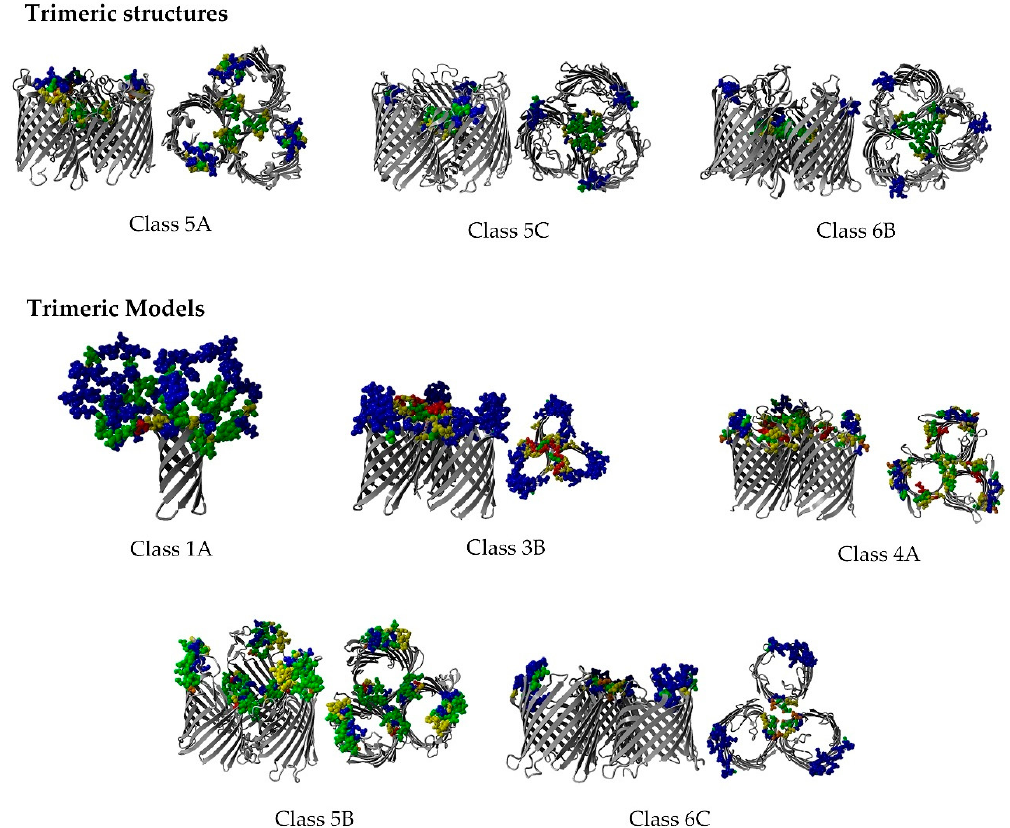
Figure 9. Porin variability. Side and top views displaying the loop variability of all protein subclasses analyzed (including the modeled trimeric interactions shown in Figure 8). All structures are visualized in the predicted trimeric form for Class 1A (2, 3, 5) and eight porins. Class 1A porins are represented in the monomeric state, and only conserved residues are highlighted (see the Discussion for more details). Red, orange and yellow represent conserved residues; green shows partially conserved residues involved in regulation; blue represents highly variable sites with unknown functions. Same as previous figures.